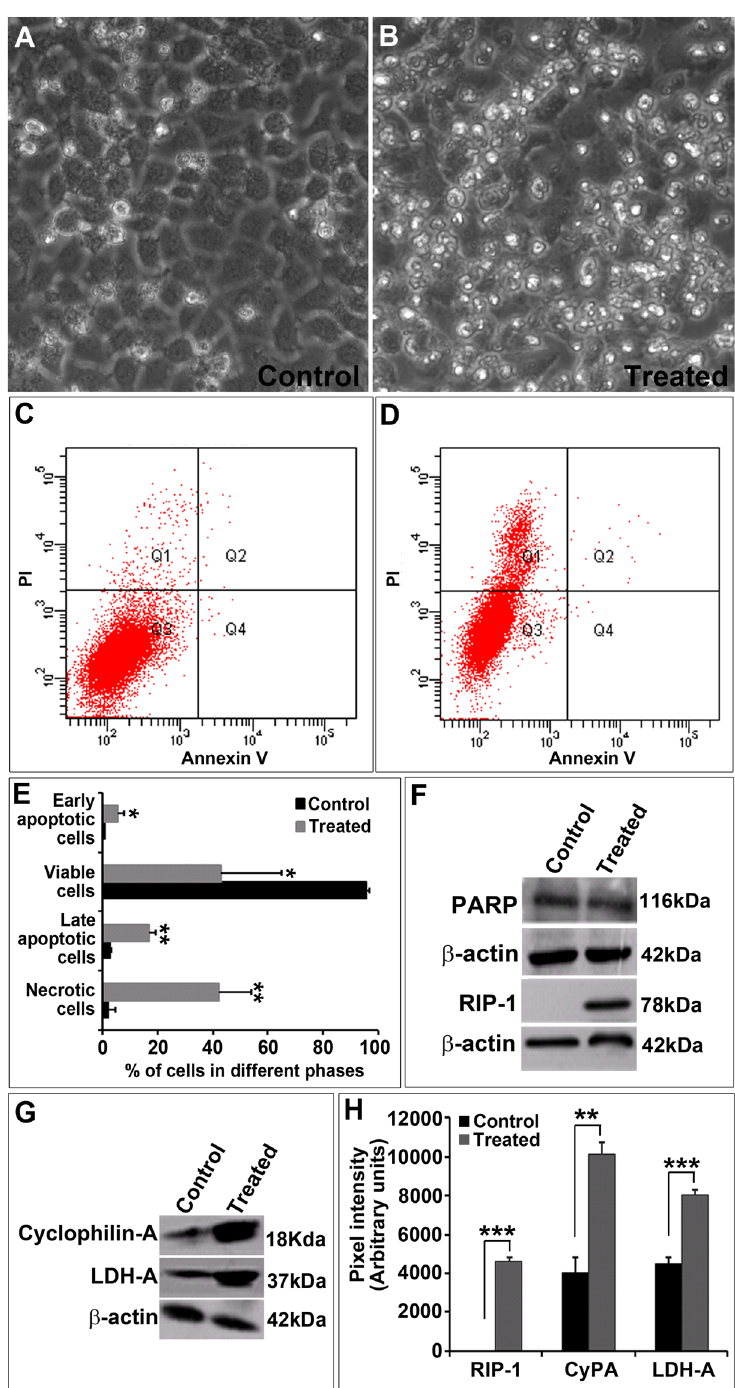
Figure 5. TALEN-mediated E7 editing in SiHa cells led to cell death by necrosis. Bright field microscopic images of ( A ) SiHa control and ( B ) TALEN treated cells. Morphological changes resembling necrosis were observed in SiHa cells ( B ). Annexin V assay in SiHa control showing 5.2% cell death in quadrant 1 ( C ), and TALEN treated cells showed 30.1% cell death in quadrant 1 ( D ) which corresponds to necrotic cell death. ( E ) Graph representing the percentage of cells in different phases. Lysates of TALEN-treated and untreated SiHa cells were immunoblotted with antibodies to PARP revealed absence of cleavage indicating that cells did not undergo apoptosis ( F ). But there was a strong expression of RIP-1 which is a marker of necrosis ( F) . Immunoblotting with antibodies against Cyclophilin A and LDH-A also pointed to that the TALEN-mediated E7 editing induced necrosis in SiHa cells ( G ). Graphical representation of the proteins levels of RIP-1, CyclophilinA and LDH-A in control and TALEN-treated SiHa Cells ( H ). Data are expressed as mean ± SD from triplicates of three different experiments. * P < 0.05, ** P < 0.001, *** P <